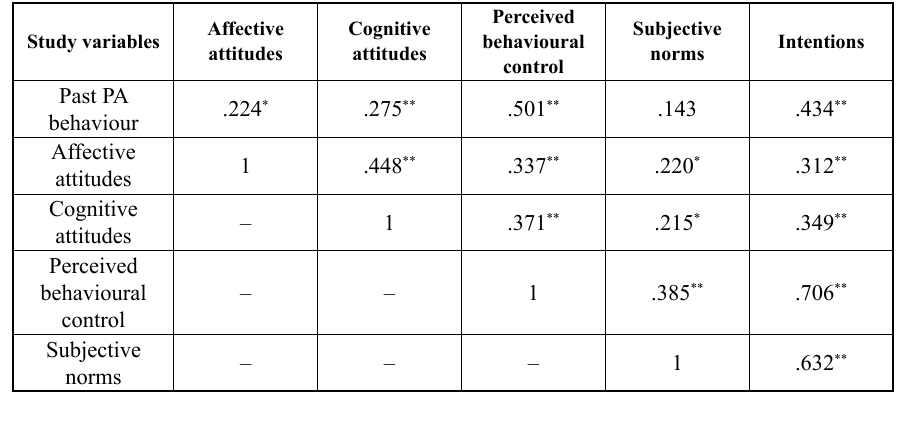
Table 3. Multiple hierarchical regression analyses predicting intention to exercise from sociodemographic, clinical, theory of planned behaviour variables and past physical activity